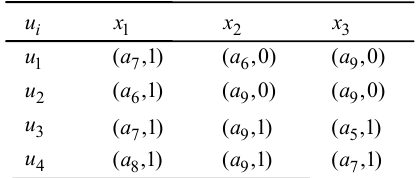
Table 5. Normalized reference information of Table 1 Table 6. Normalized reference information of Table 2